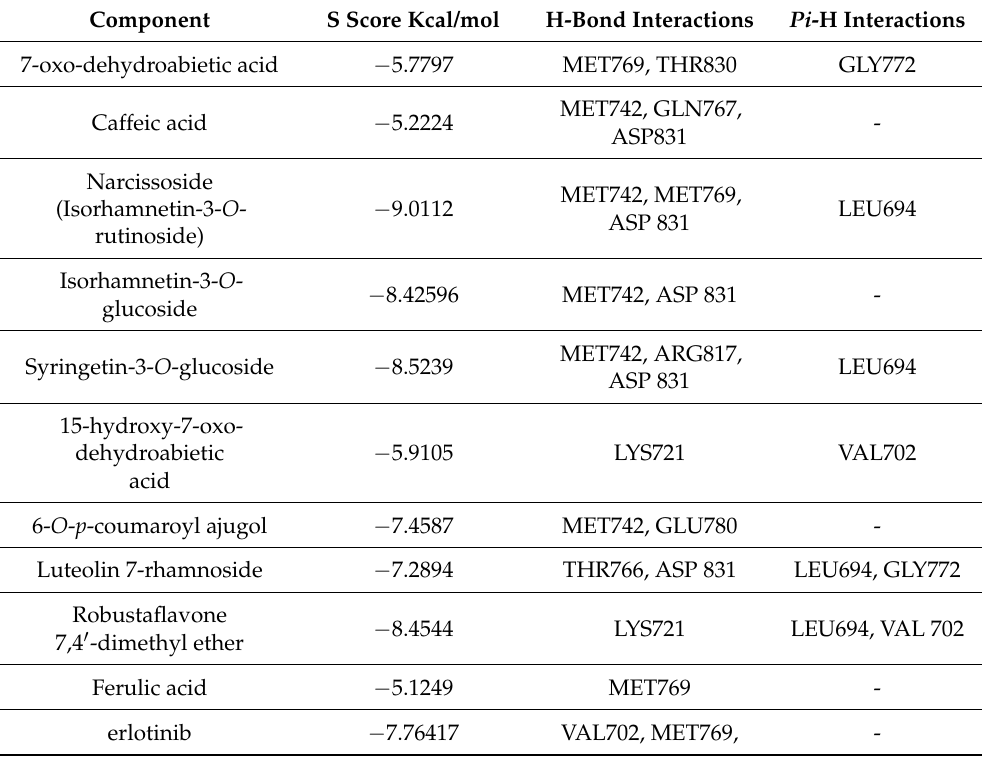
Table 4. Docking details of the selected components of ARBE on